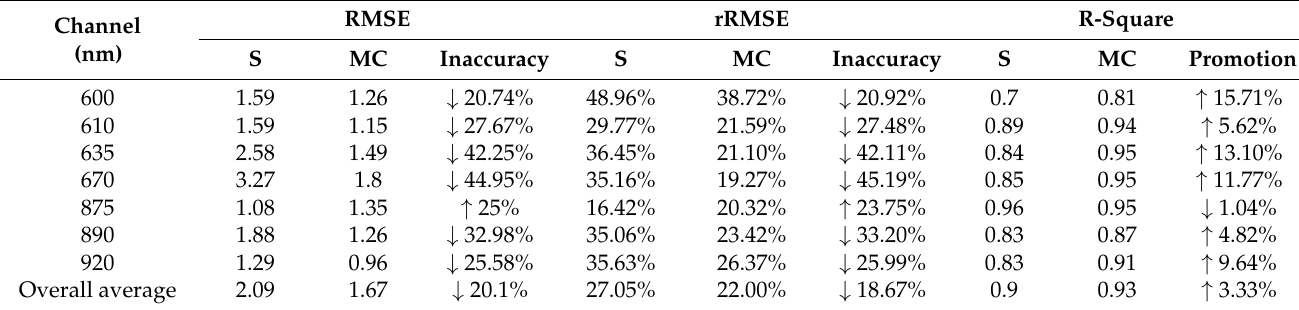
Table 4. Changes in evaluation indicators of channel data with incorrect decomposition results before and after MCMCD. S, SCWD; MC,